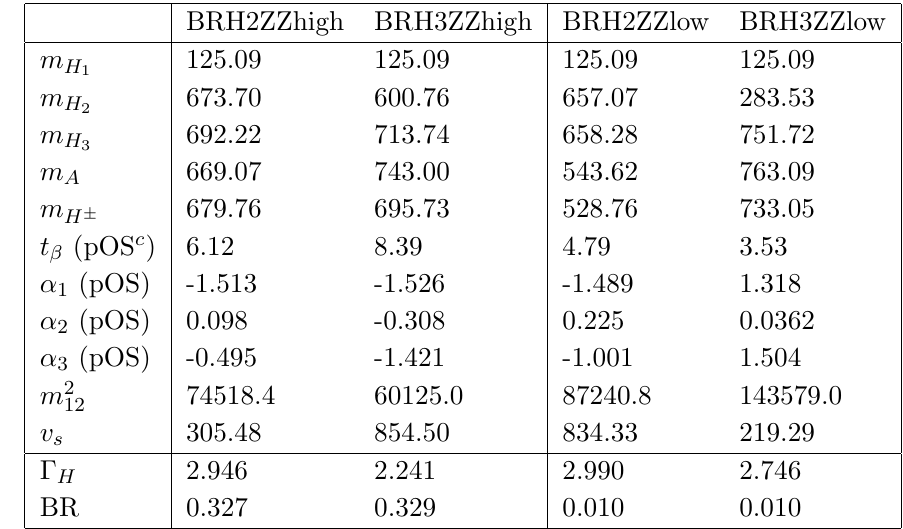
Table 6 . Input parameters for the N2HDM benchmark scenarios used in the numerical analysis of the decay processes H ! ZZ . In round brackets we specify the scheme in which (cid:11) and (cid:12) 2 = 3 are de(cid:12)ned. All masses and v S are given in GeV. The LO total width (also given in GeV) and individual branching fractions in the last two rows correspond to the Higgs state and decay each benchmark is named after, and have been generated with N2HDECAY